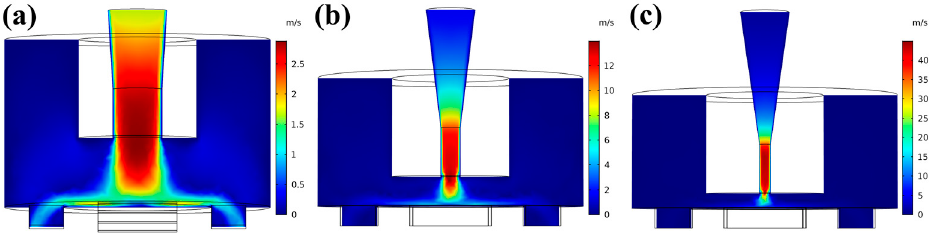
Figure 9. 3D simulation of velocity distribution of impactors: ( a ) LCP stage; ( b ) PM 2.5 – 10 stage; ( c ) PM 1 – 2.5 stage.